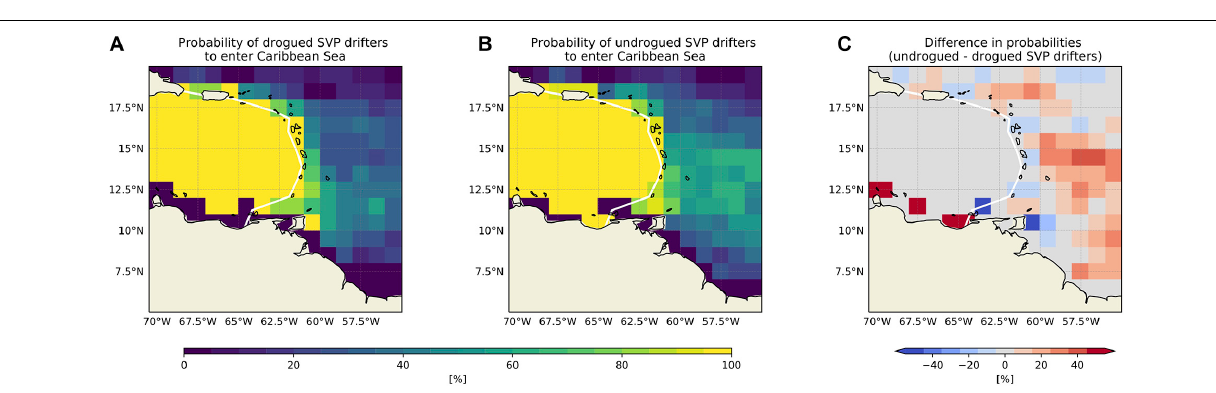
FIGURE 3 | Probability for drifters in the full six-hourly global GDP dataset to enter the Caribbean Sea, calculated for each 1 ◦ × 1 ◦ grid cell as the fraction of GDP drifters that subsequently enter the Caribbean Sea past a defined polygon (white line). Panel (A) is for the GDP drifters that still have their drogue attached; panel (B) is for the GDP drifters that have lost their drogues; panel (C) shows the difference between the undrogued and drogued